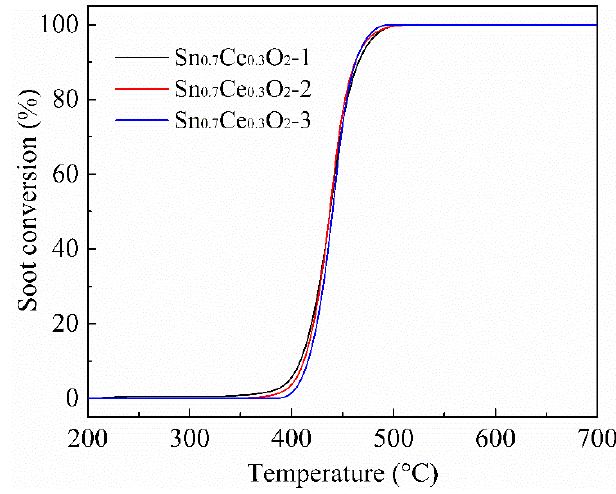
Figure 13. Repeated TPO profiles of the Sn 0.7 Ce 0.3 O 2 fiber catalyst.